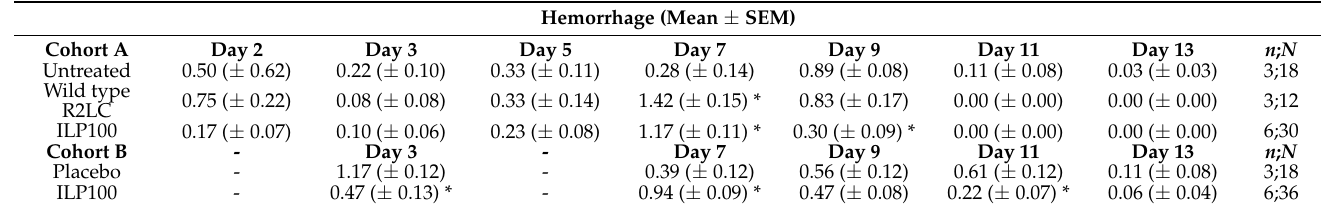
Table A3. Average score (0–4) for hemorrhage for untreated wounds, wounds treated with wild type L. reuteri R2LC or ILP100 in Cohort A and wounds treated with placebo or ILP100 wounds in Cohort B. For time points not included in the table, all wounds in all groups were scored as 0. * p < 0.05.